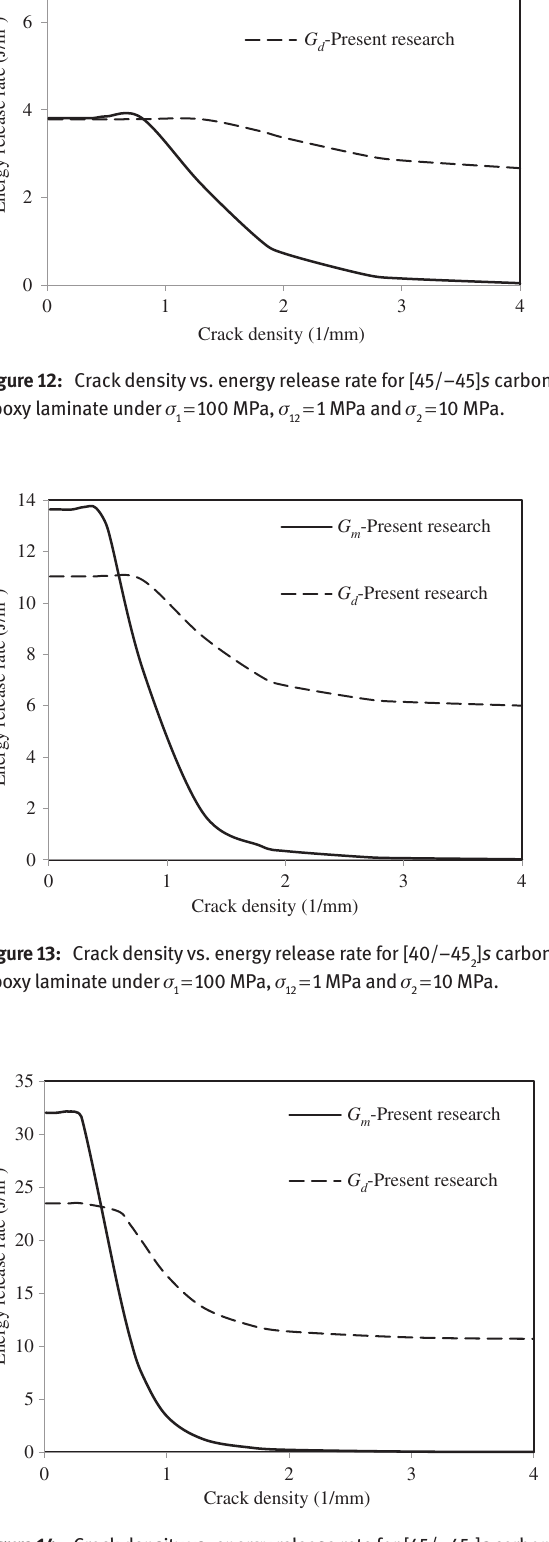
Figure 17: Crack density vs. energy release rate for [40/−40 epoxy laminate under σ